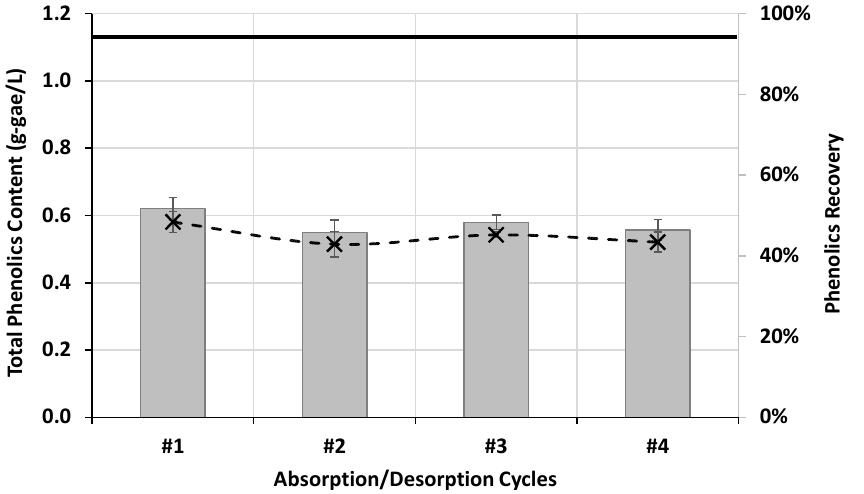
Figure 4. Phenolic compounds (TPC) in the recovered extracts (x, dashed line ) and corresponding percentage of phenolics recovery ( columns ) in four absorption/desorption cycles of 15 BV in the HP-20 resin. Solid line marks the maximum amount of phenolic compounds, considering the eluted feed.